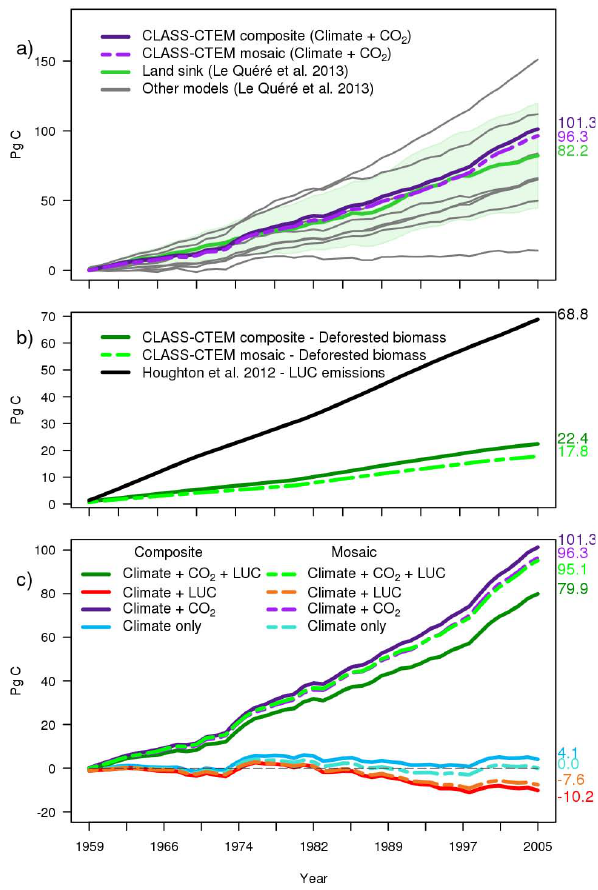
Fig. 4. CLASS-CTEM results from the transient simulations over the 1959–2005 period using the composite and mosaic approaches. (a) The simulated cumulative atmosphere–land CO 2 flux ( ˜ F Ln ) from the Climate + CO 2 simulation in comparison with other ter- restrial vegetation model estimates and the estimated residual land sink from Le Quéré et al. (2013). None of the model results in- clude LUC and all simulations/estimates account for changing cli- mate and atmospheric (CO 2 ). (b) Deforested biomass from the Cli- mate + CO 2 + LUC simulation alongside the bookkeeping-based estimate of LUC emissions from Houghton et al. (2012). (c) Results from the four different transient simulations using different combi- nations of climate, (CO 2 ), and LUC forcings. The model setup for each run is described in Sect. 2.5 and Table 1. Negative and positive ˜ F ˜ F L and Ln values indicate net carbon release from the land surface to the atmosphere and uptake by the land surface,